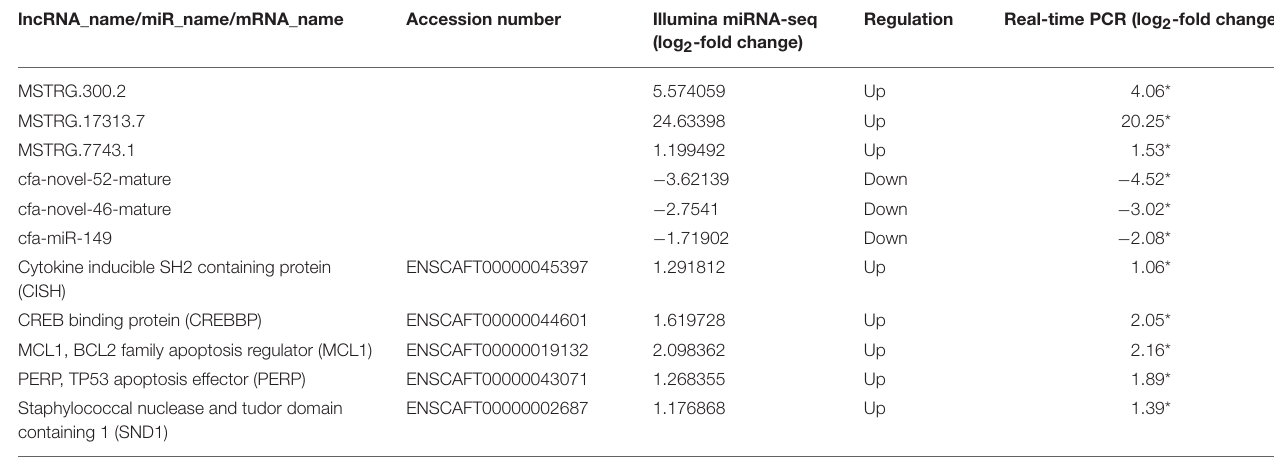
TABLE 3 | Relative RNA expression of selected differentially expressed genes (DEGs) determined using RNA-seq and quantitative real-time PCR